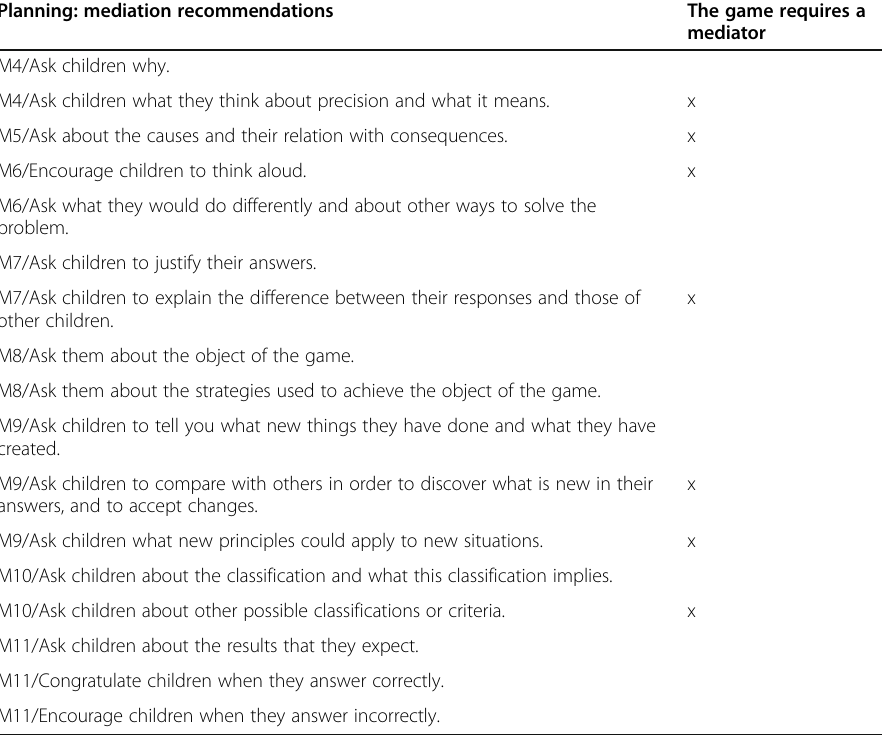
Table 5 Planning: mediation recommendations for interactive serious games Planning: mediation recommendations The game requires a